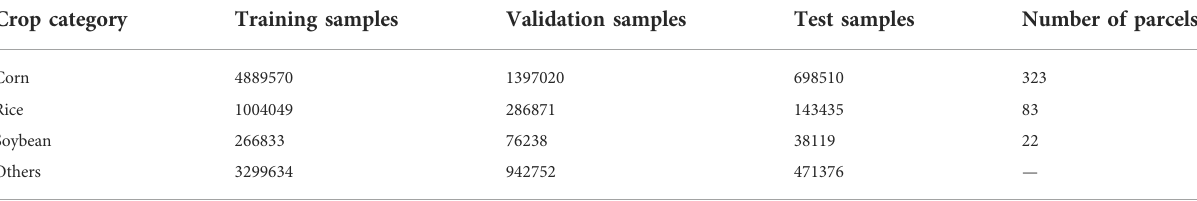
TABLE 1 Number of instances of each crop class counted at polygon- and